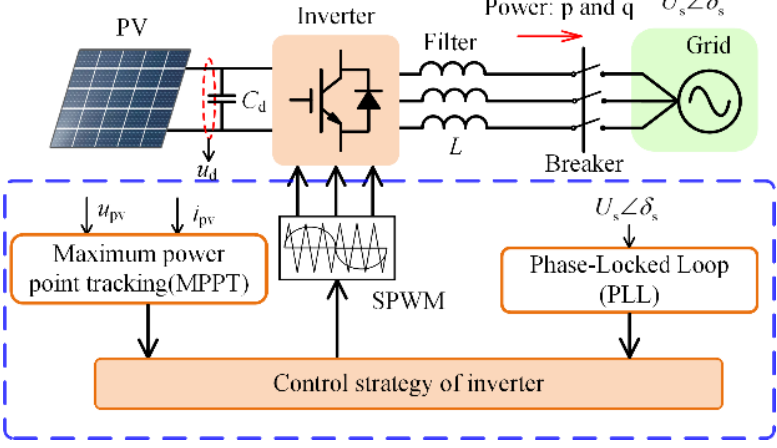
Figure 1. Structure of the proposed single-stage grid-connected PV system.